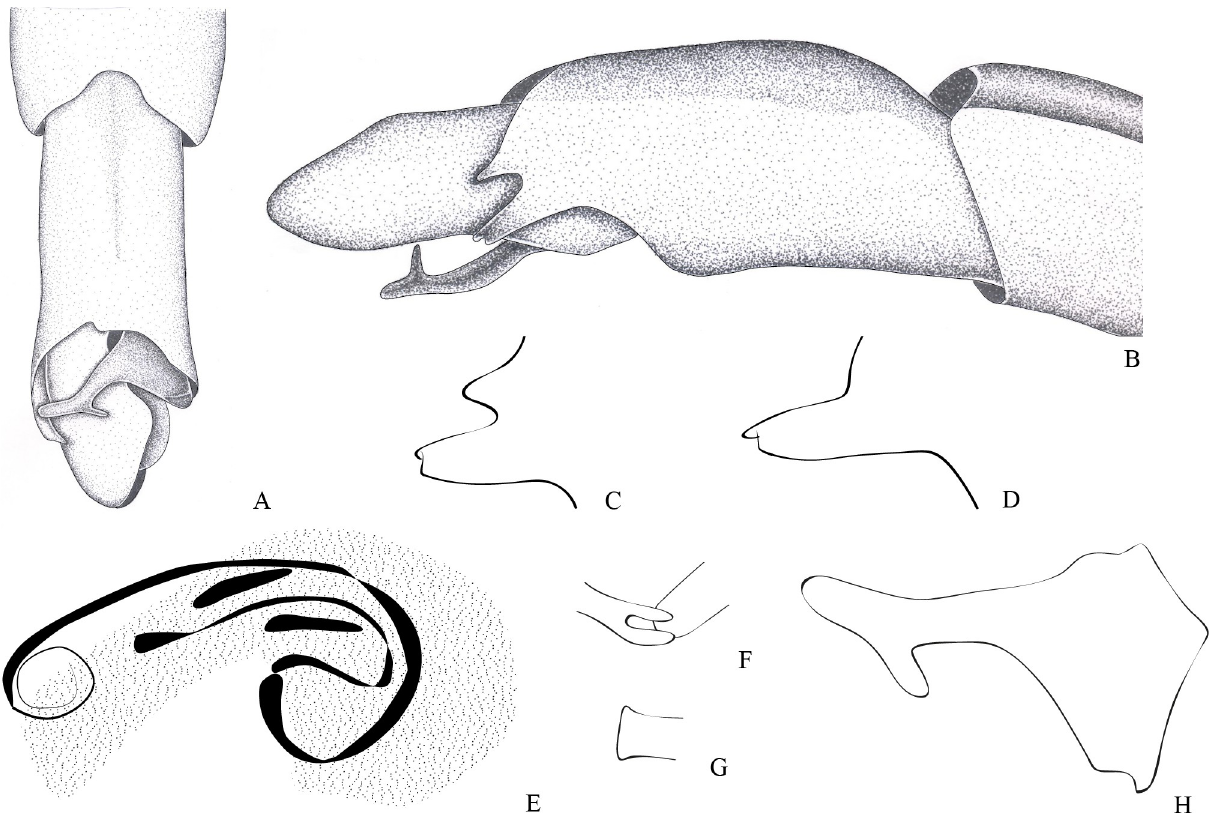
Fig 11. Potamobates variabilis . (A) Male, terminalia, ventral view; (B) male, terminalia, right lateral view; (C-D) Variation of projections on the right posterolateral margin of male abdominal segment; (E) phallus, lateral view; (F) junction between dorsal and ventral sclerite; (G) base ventral sclerite; (H) proctiger, dorsal